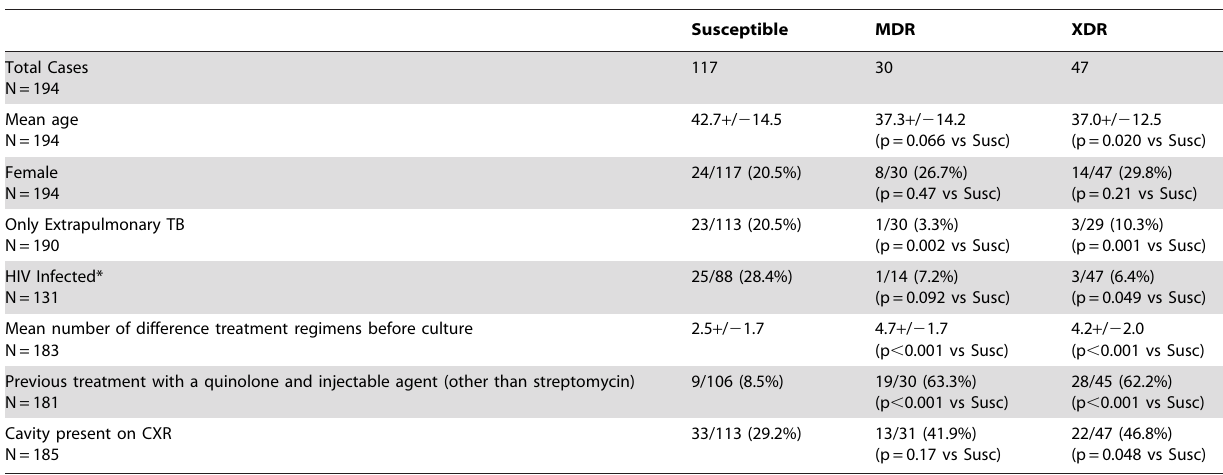
Table 1. Description of Cases.